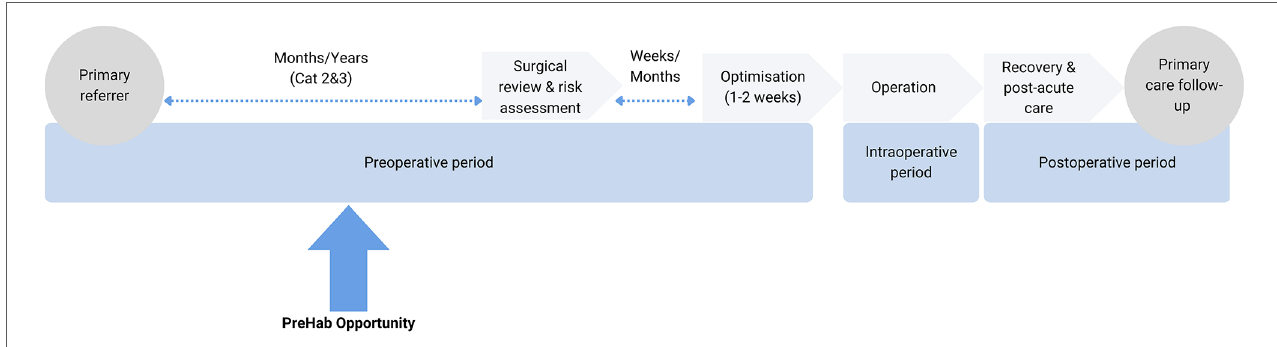
FIGURE 1 Perioperative timeline (adapted from ANZCA 2019)